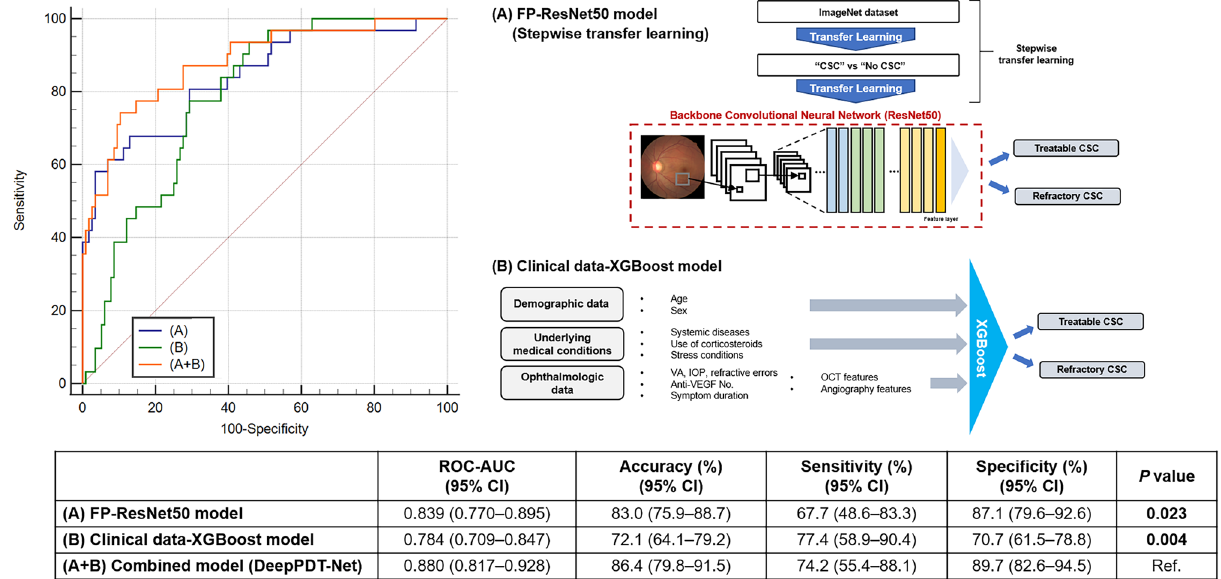
Figure 2. Receiver operating characteristic (ROC) curves with a table showing model performance for predicting cases of refractory central serous chorioretinopathy (CSC) in the five-fold cross validation using the Severance Eye Hospital dataset. ( A ) Domain-specific fine-tuned ResNet50 model developed using initial fundus photographs (FPs); ( B ) XGBoost model trained exclusively on clinical data; and (A + B) combined model that integrates the deep features of FPs extracted by ResNet50 and other clinical data. (A + B) DeepPDT-Net (Fig. 6) had a greater area under the curve (AUC) value of 0.880 compared with ( A ) the ResNet50 model, which had an AUC value of 0.839. CI = confidence interval. A P value in bold indicates statistical significance ( P <